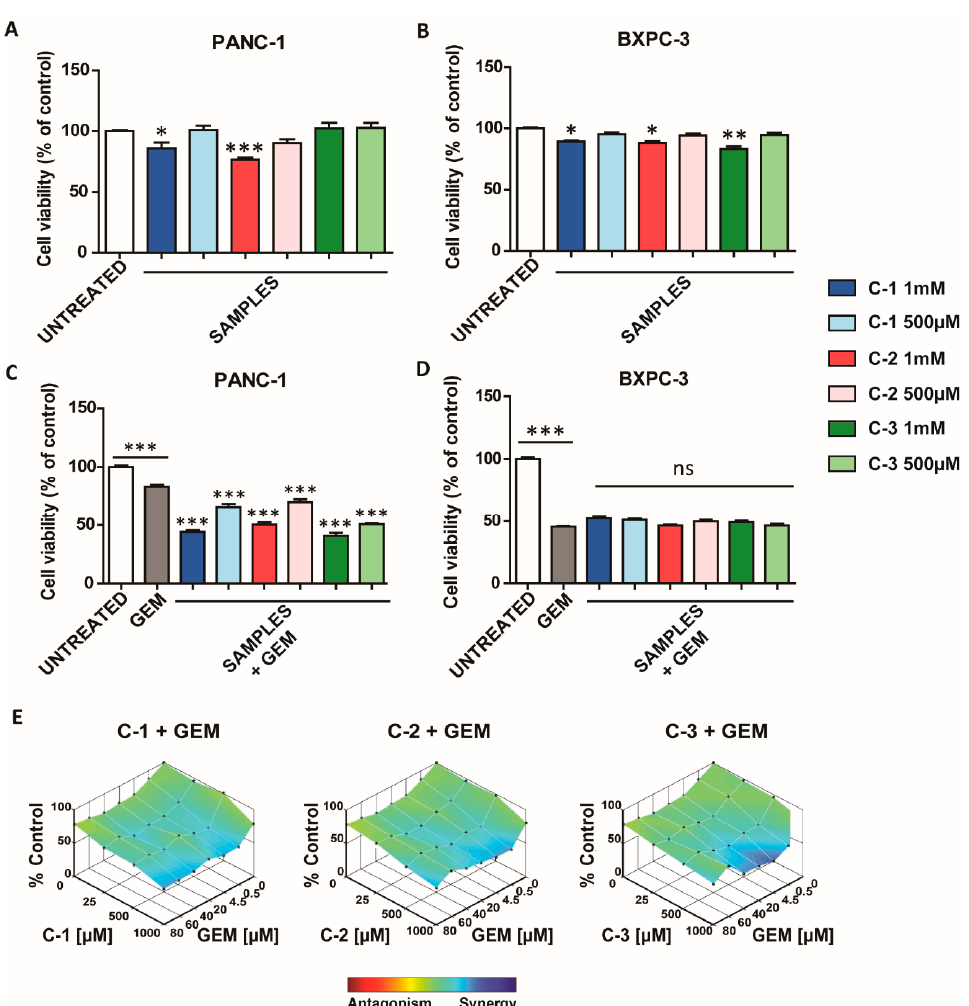
Figure 2. Antitumoral activity of coordination polymers (CPs). ( A , B ) Cell viability studies in pancreatic cancer cell lines treated with C-1, C-2 , and C-3 for 48 h. ( C , D ) Cell viability studies in pancreatic cancer cell lines treated with 4.5 µ M gemcitabine (GEM) and C-1 , C-2 , and C-3 for 48 h. The values of treated cells were normalized to the untreated controls and reported as mean ± SEM. Statistical analysis was performed using one-way ANO VA (each group vs. control). (*** p < 0.001, ** p < 0.01, * p < 0.05). ( E ) Combenefit-mapped surface output for the drug combinations involving C-1 , C-2 , and C-3 with GEM in PANC-1 cells. The concentrations of each drug are plotted along the horizontal axes, while the percentages of cells remaining relative to untreated controls are plotted on the vertical axes. A heat map is used to represent the level of synergy (blue color) at each concentration. All experiments were conducted at least three